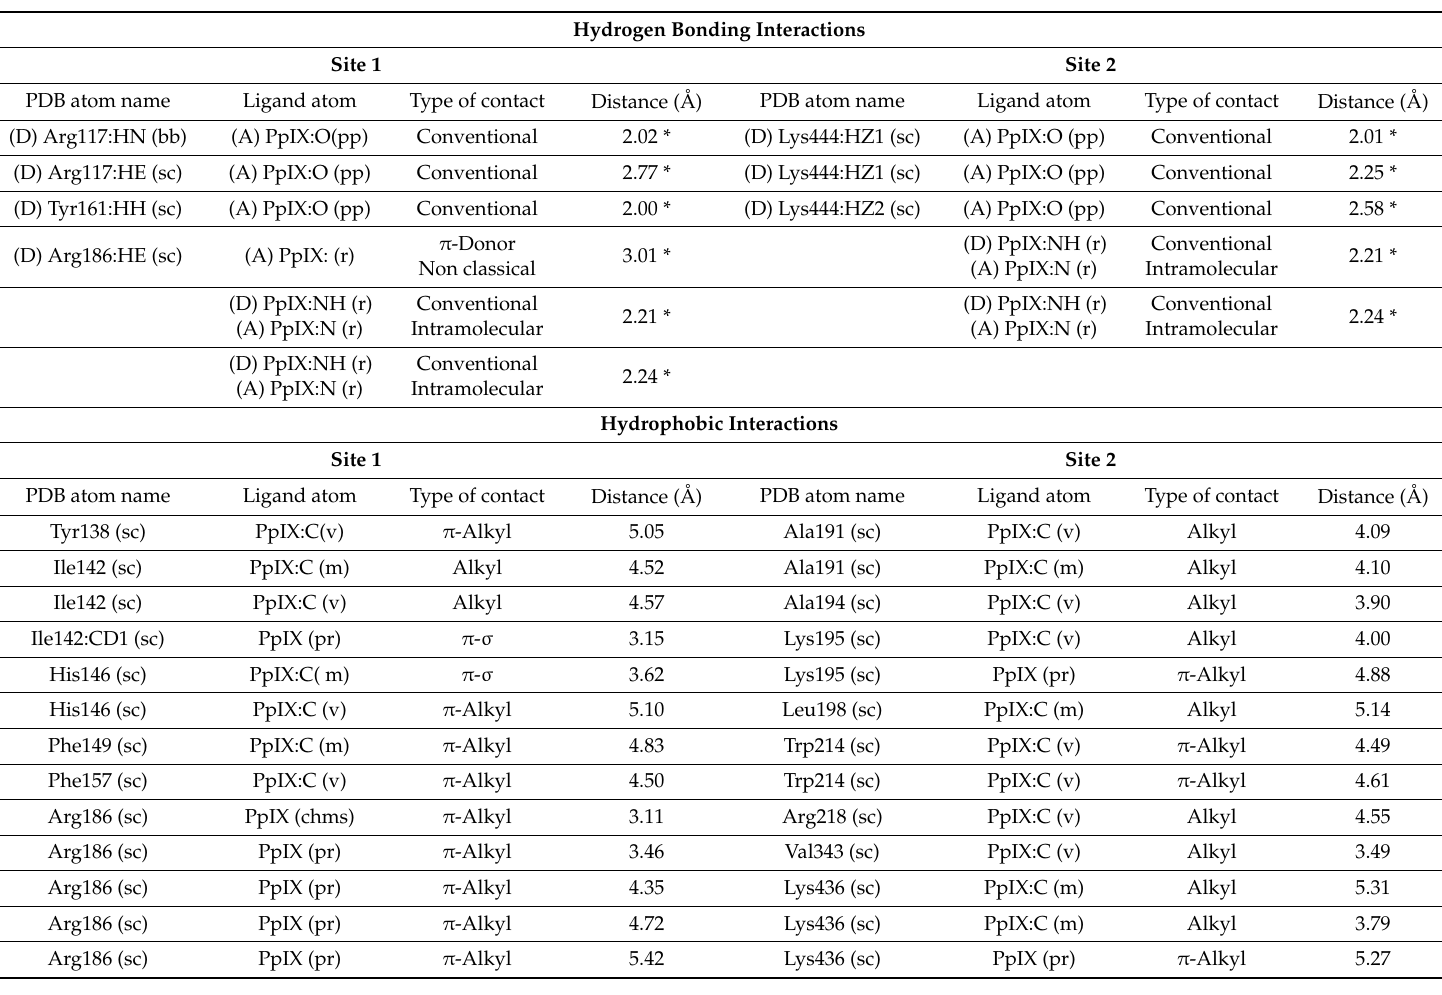
Table 3. Key protein-ligand contacts of bound PpIX to the ligand binding Sites 1 and 2 inside HSA (1AO6.pdb). Computational data obtained using the CLC DDWB program [23] and BIOVIA DS Visualizer software